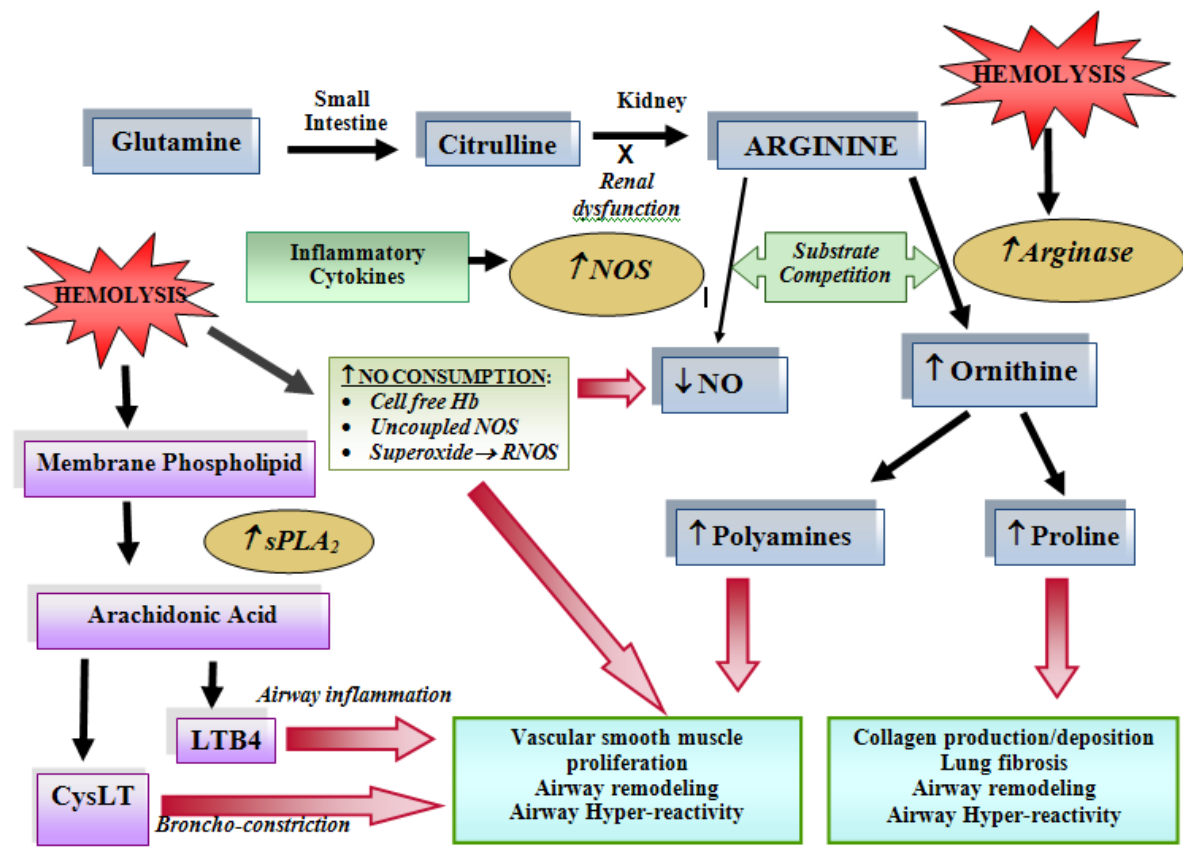
FIGURE 1. Novel paradigm of hemolysis-associated AHR and an “asthma-like” condition in SCD. Dietary glutamine serves as a precursor for the de novo production of arginine through the citrulline-arginine pathway. Arginine is synthesized endogenously from citrulline primarily via the intestinal-renal axis. Arginase and NOS compete for arginine, their common substrate. In SCD, bioavailability of arginine and NO is decreased by several mechanisms linked to hemolysis. The release of erythrocyte arginase during hemolysis increases plasma arginase levels and shifts arginine metabolism toward ornithine production, limiting the amount of substrate available for NO synthesis. The bioavailability of arginine is further diminished by increased ornithine levels because ornithine and arginine compete for the same transporter system for cellular uptake[57]. Despite increases in NOS, NO bioavailability is low due to low substrate availability[57], NO scavenging by cell-free hemoglobin released during hemolysis[99] NOS uncoupling[100], and through reactions with free radicals, such as superoxide and other reactive NO species[101]. Superoxide reacts with NO to form reactive NO species (RNOS), including peroxynitrite, which can contribute further to cell damage and cell death[64]. Endothelial dysfunction resulting from NO depletion and increased levels of the downstream products of ornithine metabolism (polyamines and proline) likely contribute to the pathogenesis of lung injury, asthma, and pulmonary hypertension in SCD[65]. As a result of hemolysis, membrane phospholipids are hydrolyzed by secretory phospholipase A2 (sPLA2) into arachidonic acid (AA). AA metabolism via the 5-lipoxygenase pathway leads to formation of CysLT and LTB4. LTB4 is an important chemoattractant of neutrophils and plays an important role in airway inflammation[53]. In airways, CysLT cause bronchoconstriction[56], smooth muscle proliferation, airway edema, and mucus production[55], whereas in vasculature, they cause vasoconstriction, vascular leakage, and up-regulation of cellular adhesion molecules. (Modified with permission from the American Society of